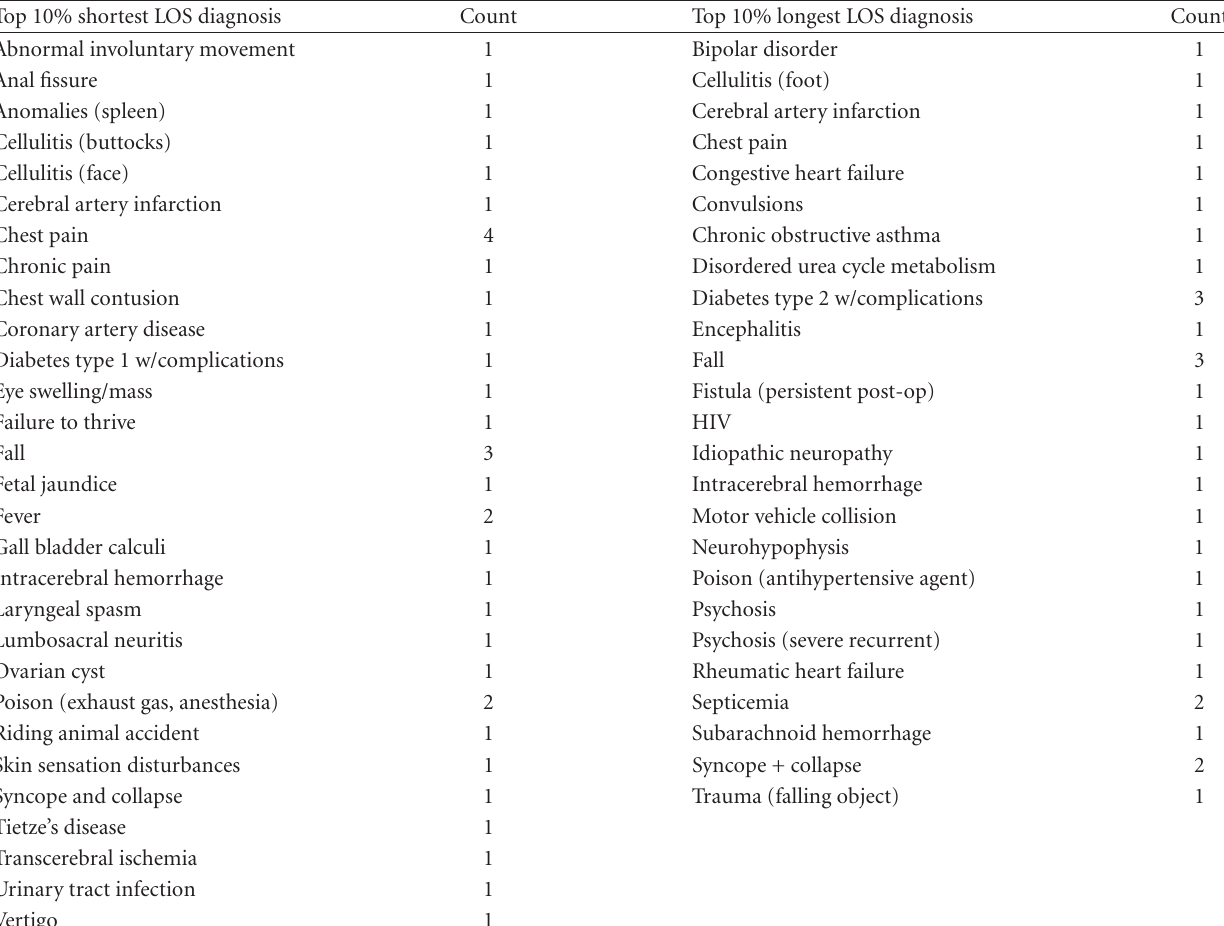
Table 3: Top 10% shortest and longest length of stay